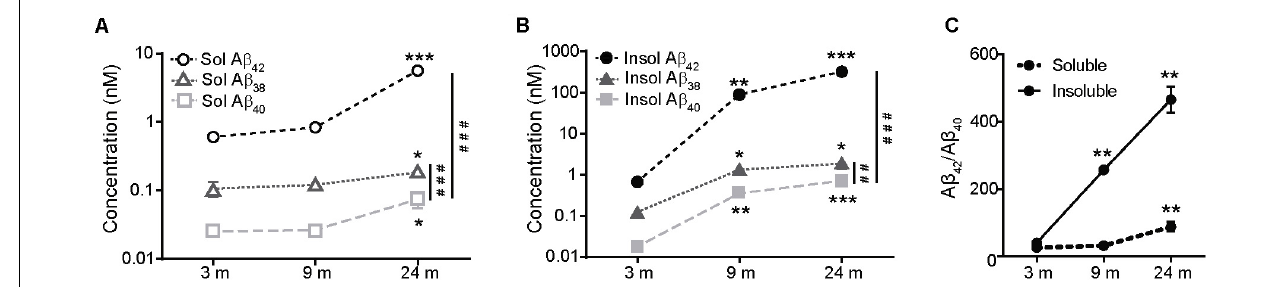
FIGURE 1 | The levels of A β species increase in the cerebral cortex of APP NL/F during aging. (A) Quantification using the MSD-Vplex assay of the A β species present in the soluble extracts from the cerebral cortex of 3, 9, and 24 months-old APP NL/F mice. A β levels at 9 and 24 months were compared to 3 months ( n = 4 mice per age and genotype; * p < 0.05, *** p < 0.001 vs. 3 months; ### p < 0.001 vs. A β 40). (B) Quantification using the MSD-Vplex assay of the A β species present in the insoluble extracts from the cerebral cortex of 3, 9, and 24 months-old APP NL/F mice. A β levels at 9 and 24 months were compared to 3 months ( n = 4 mice per age and genotype; * p < 0.05, ** p < 0.01, *** p < 0.001 vs. 3 months; ## p < 0.01, ### p < 0.001 vs. A β 40). (C) Changes of the pathologically relevant A β 42/A β 40 ratio over aging were plotted for insoluble and soluble A β by using the raw data shown in panels (A,B) . A β 42/A β 40 ratio at 9 and 24 months was compared to 3 months ( n = 4 mice per age and genotype; ** p < 0.01). Statistical significance was analyzed by one-way ANOVA followed by Tukey post hoc